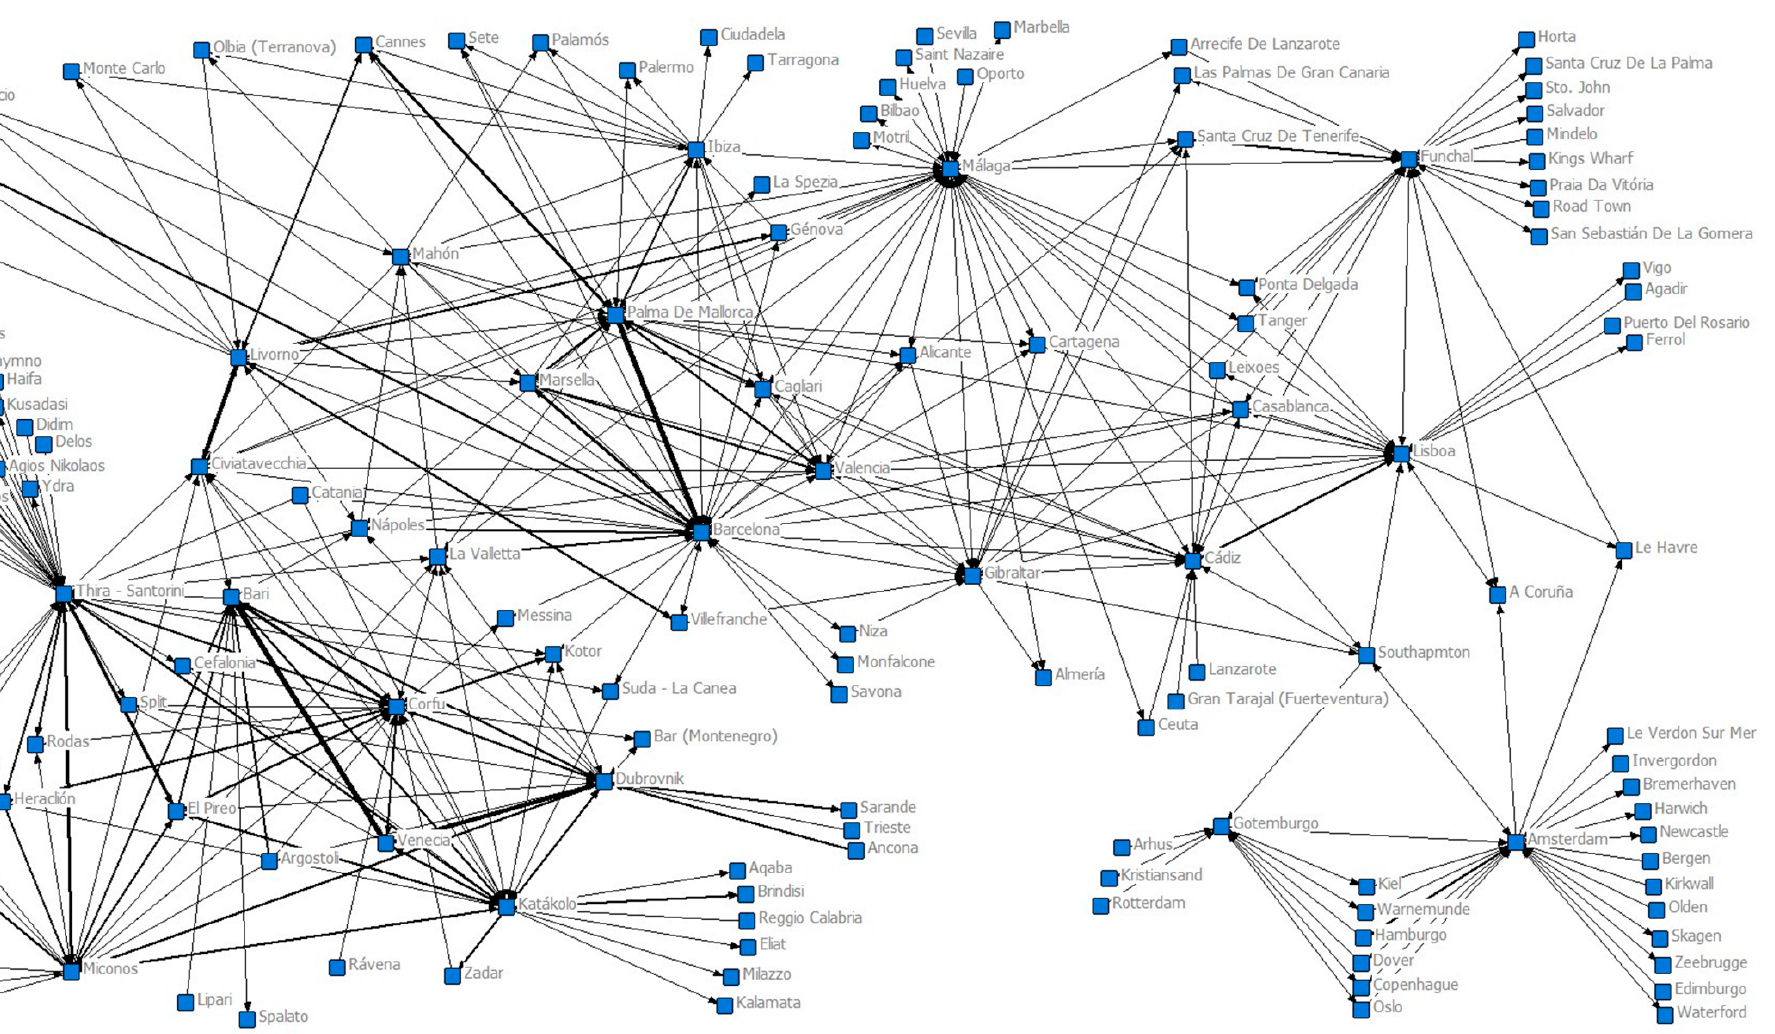
Figure 6. Interrelations of contemporary cruise port network in Southern Europe in 2018. Source: Authors elaboration. Note: The thickness of the lines indicates the traffic intensity between ports.